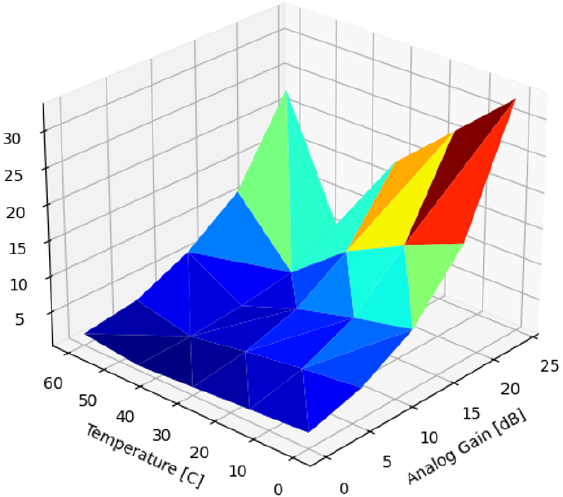
Figure 12. Standard deviation of DSNU corrected with a single, scaled